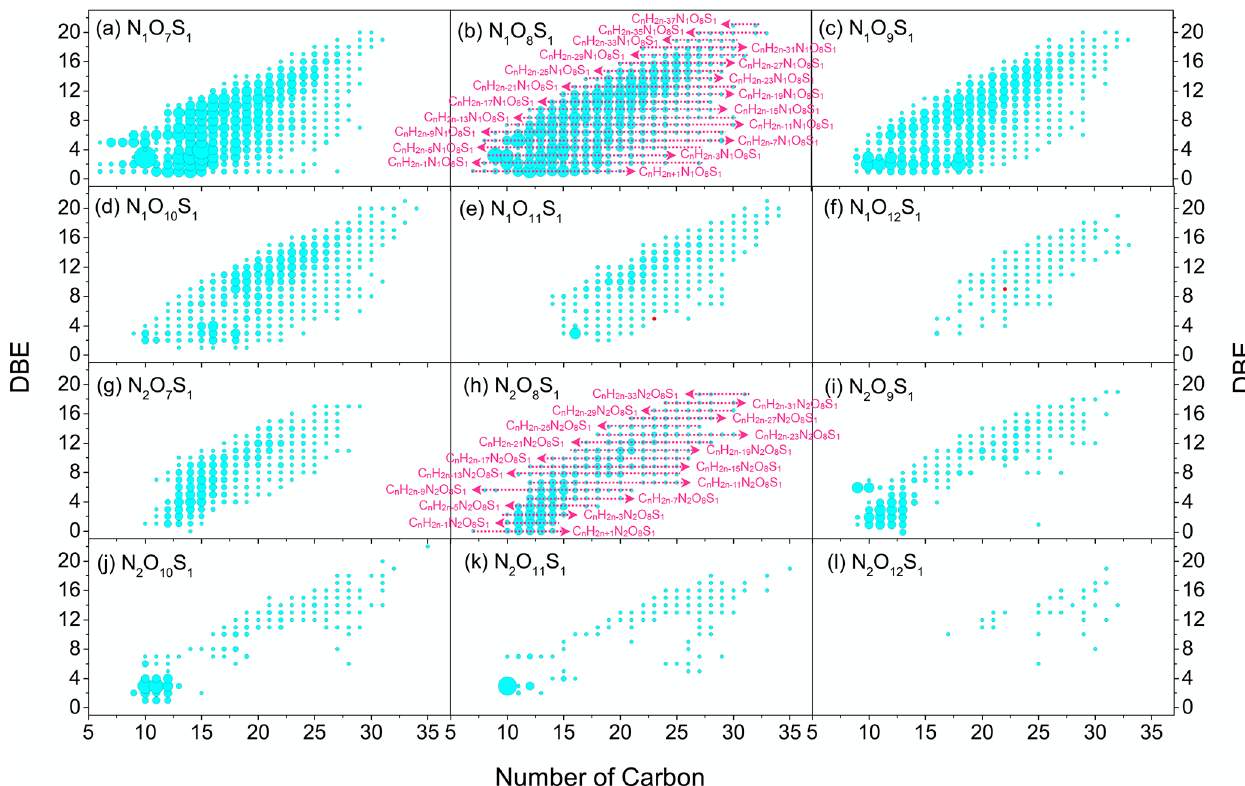
Figure 5. Molecular formulae distributions of N 1 O 7 S 1 –N 1 O 12 S 1 and N 2 O 7 S 1 –N 2 O 12 S 1 class species. The C and DBE number distributions of N 1 O n S 1 and N 2 O n S 1 class species in the NYE N sample. The size of the symbols reflects the relative peak magnitudes of nitrooxy OSs on a logarithmic scale. The pink arrows and molecular formulae in N 1 O 8 S 1 and N 2 O 8 S 1 class species display the elemental composition of compounds as an example for all